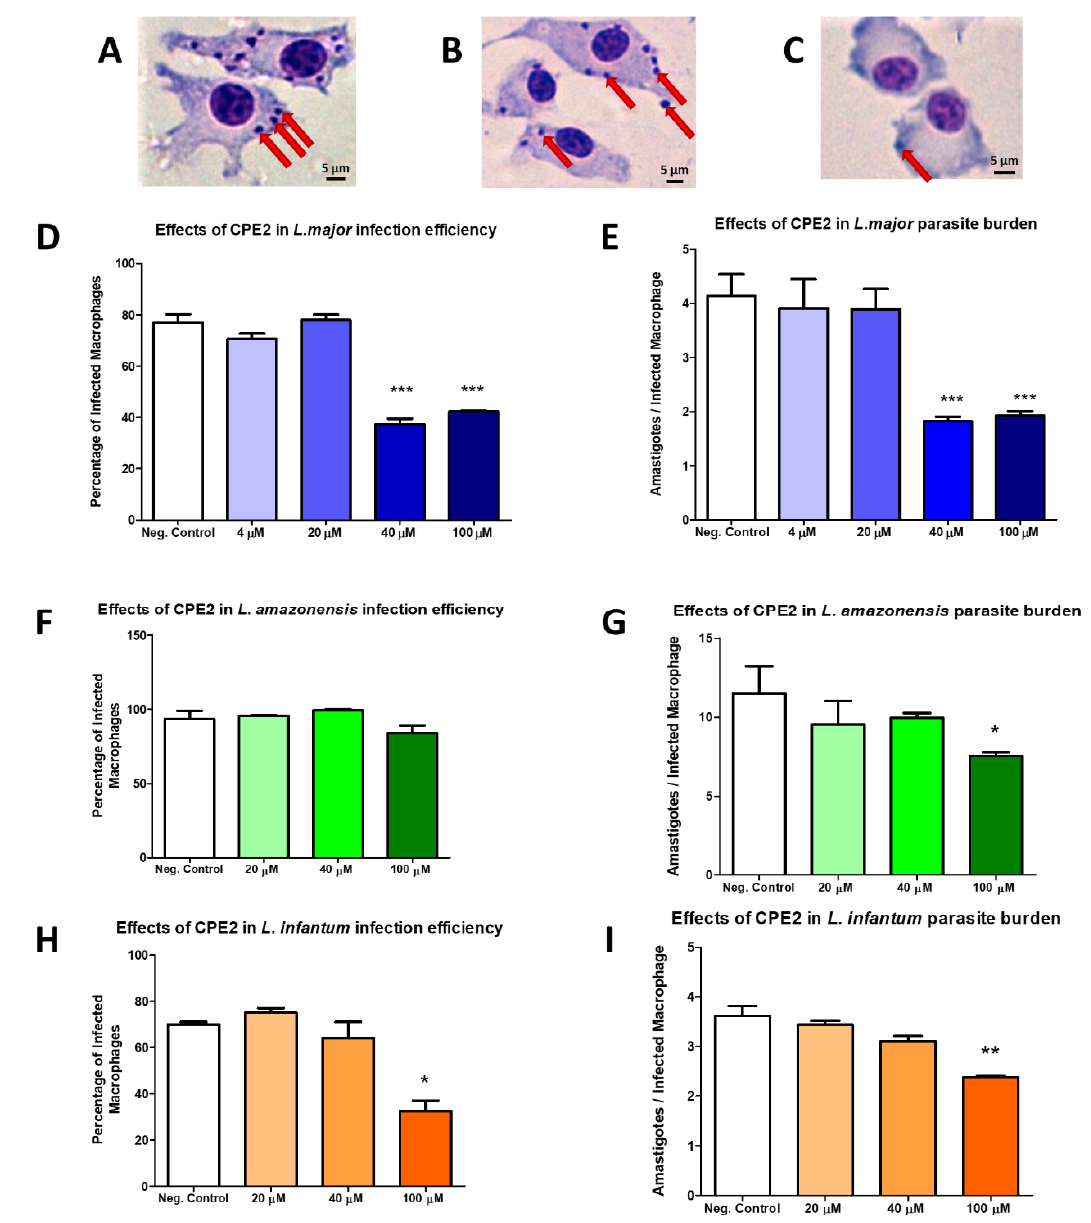
Figure 8. Effects of CPE2 on intracellular amastigotes of L. major, L. amazonensis , and L. infantum . Representative pictures of ( A ) L. major in vitro infection negative control, ( B ) L. major in vitro infection treated with 20 µM CPE2, ( C ) L. major in vitro infection treated with 100 µM of CPE2. The red arrows indicated the amastigotes. The scale bar in black represented 5 µ m. The drug treatment was performed at four different concentrations: 4, 20, 40, and 100 µ M CPE2. Bars represented the percentage of infected macrophages ( D , F , H ) or the number of parasites per infected cell ( E , G , I ) and after 48 h of treatment. Negative controls represented the untreated cells. The results showed the means from three independent duplicate experiments ± SD. Significant reductions in the proportion of infected amastigotes, as well as in the count of amastigotes per infected macrophage were annotated (*, p < 0.05. **, p < 0.01. ***, p <